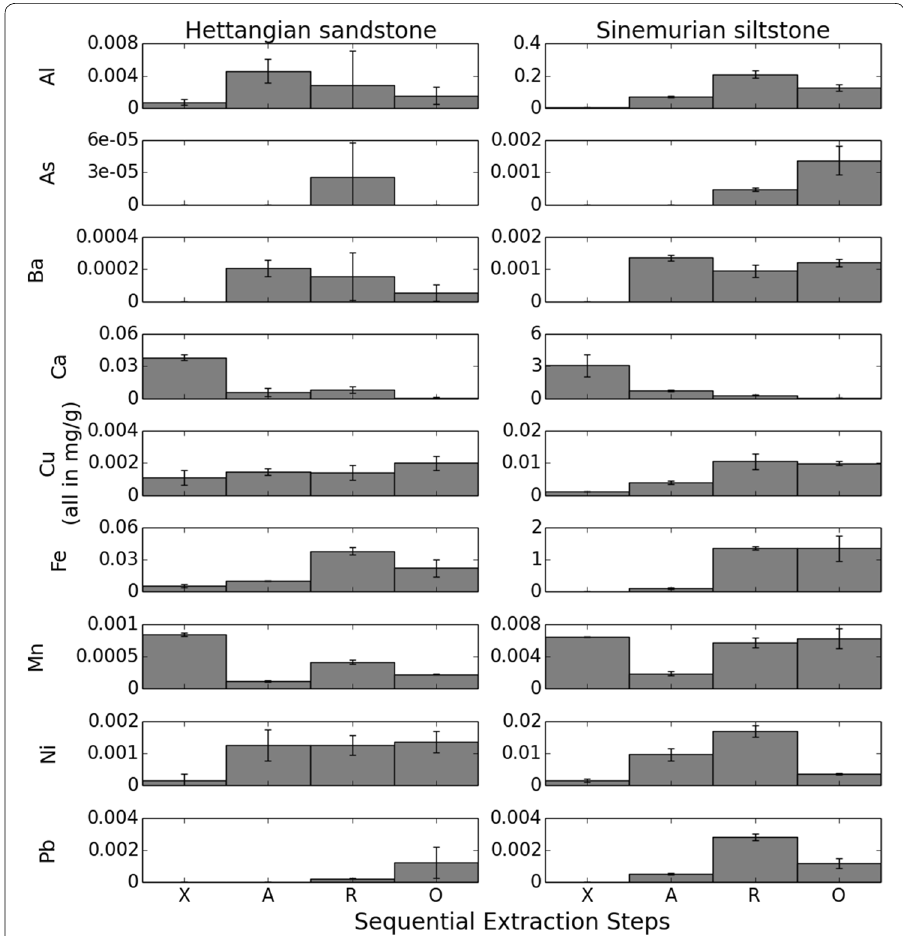
Fig. 1 Mass fractions (mg/g sediment) and phase associations of mobile elements in the sampled rocks, as determined by sequential extraction with 1 g of rock and 30 mL of solvent. The phases are X , exchangeable; A , acid-soluble; R, reducible; O oxidizable Data taken from Müller et al.